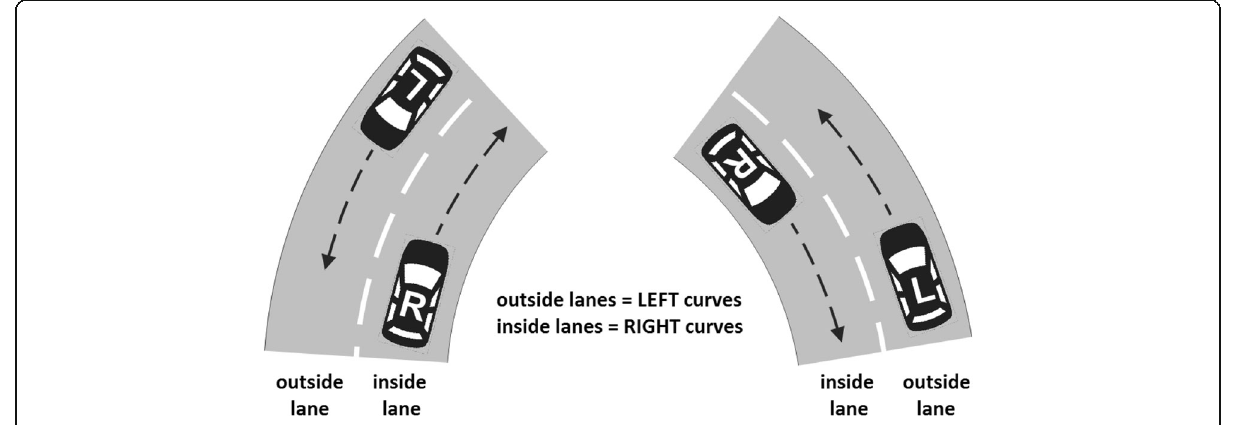
Fig. 2 Illustration of terminology: from driver perspective, outside/inside lanes are left/right curves